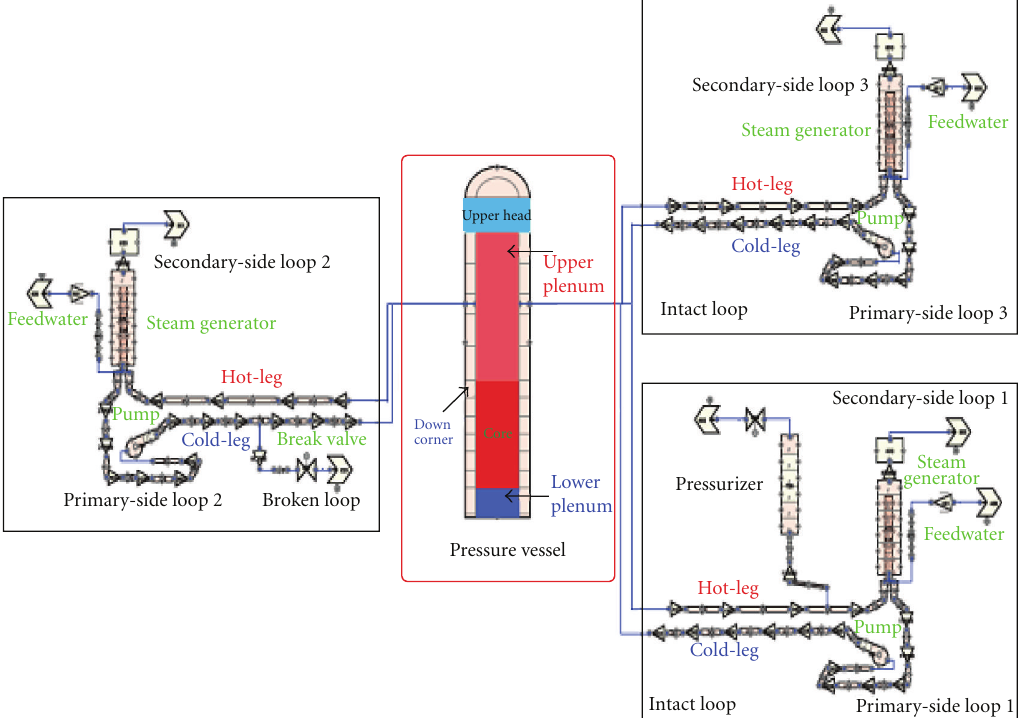
Figure 1: The TRACE model for IIST